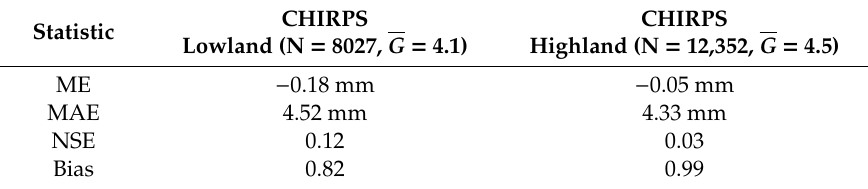
Table 5. Result of statistical continuous metrics analysis of performance of CHIRPS at the Beles Basin, comparing daily rainfall of the CHIRPS rainfall with ground gauge data of the lowland and highland stations during 2005–2015. N indicates the number of data pairs compared and G is the average daily rainfall (mm) of the gauge